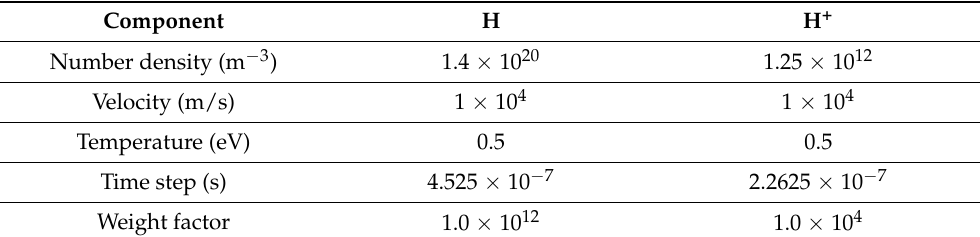
Table 4. Hybrid DSMC/PIC algorithm injection parameters.